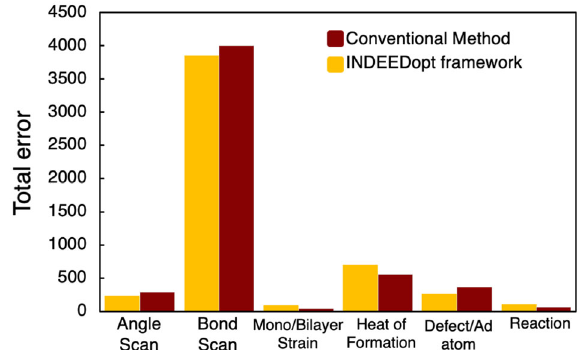
Fig. 8 The comparison of error values calculated by INDEEDopt and conventional method. The total error values corresponding to different parts of the tungsten – sul fi de – carbon – hydrogen FF- training set calculated by INDEEDopt with brute force and conventional methods. An explanation of the naming for different parts of FF-training set can be seen in Supplementary Note 2, and also same structures are used in ref. 6